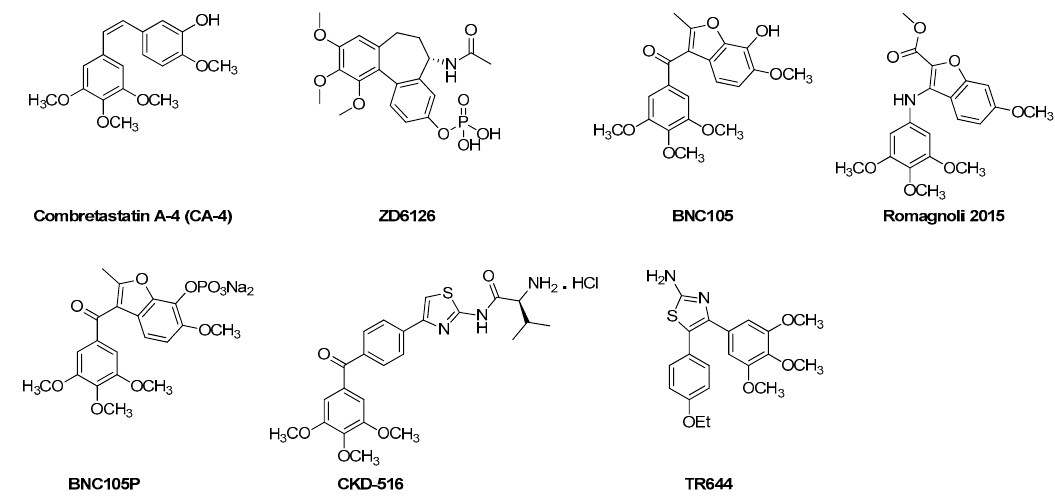
Figure 3. Recently developed VDAs and antiangiogenic agents from the CA-4 family.